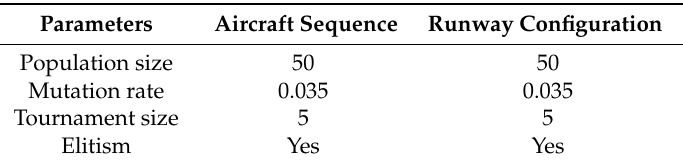
Table 3. Parameters used for the